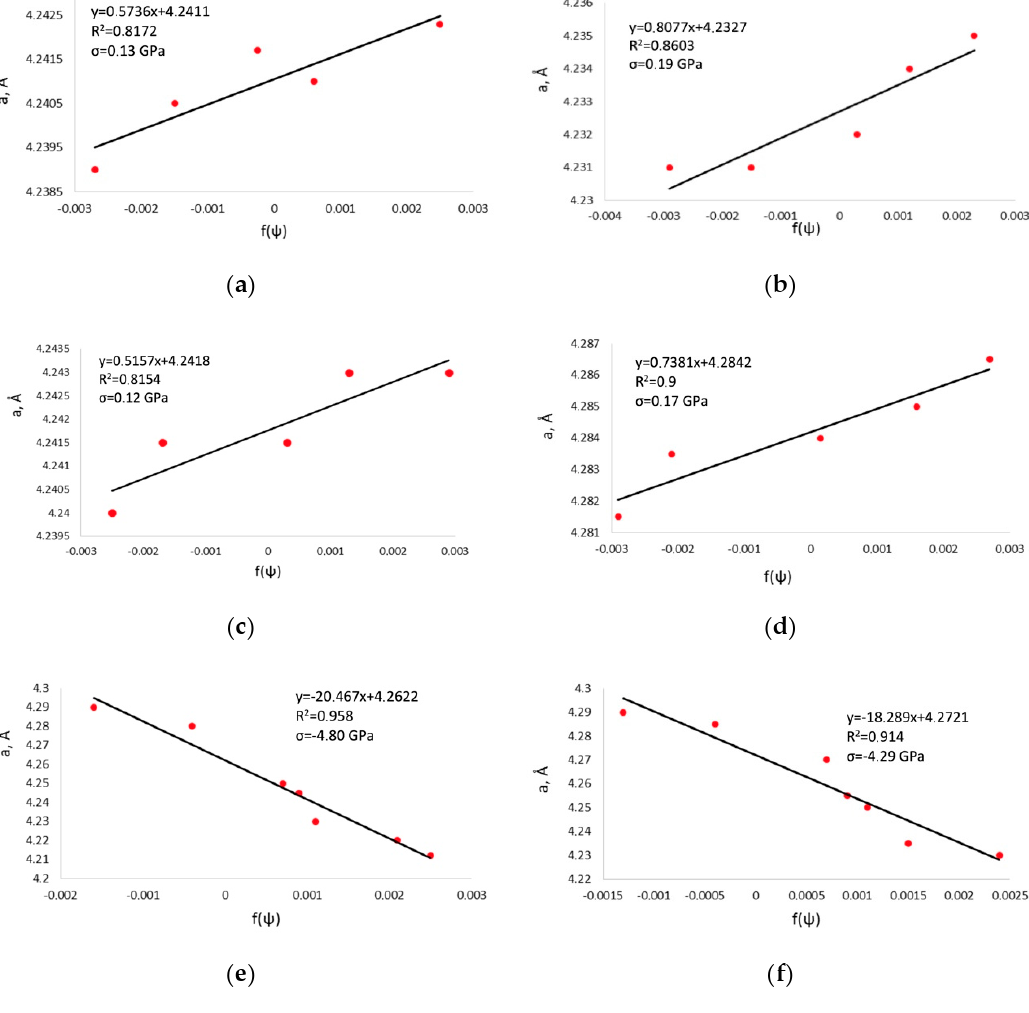
Figure 6. Lattice parameter a Ψ (Ti,Al)N as a function of f ( ψ ) = 1 Ti–Al–Cu–N ( a , b ); Ti–Al–Ni–N ( c , d ); and Ti–Al–N ( e , f ) deposited onto silicon ( a , c , e ) and carbide inserts ( b , d , f ).